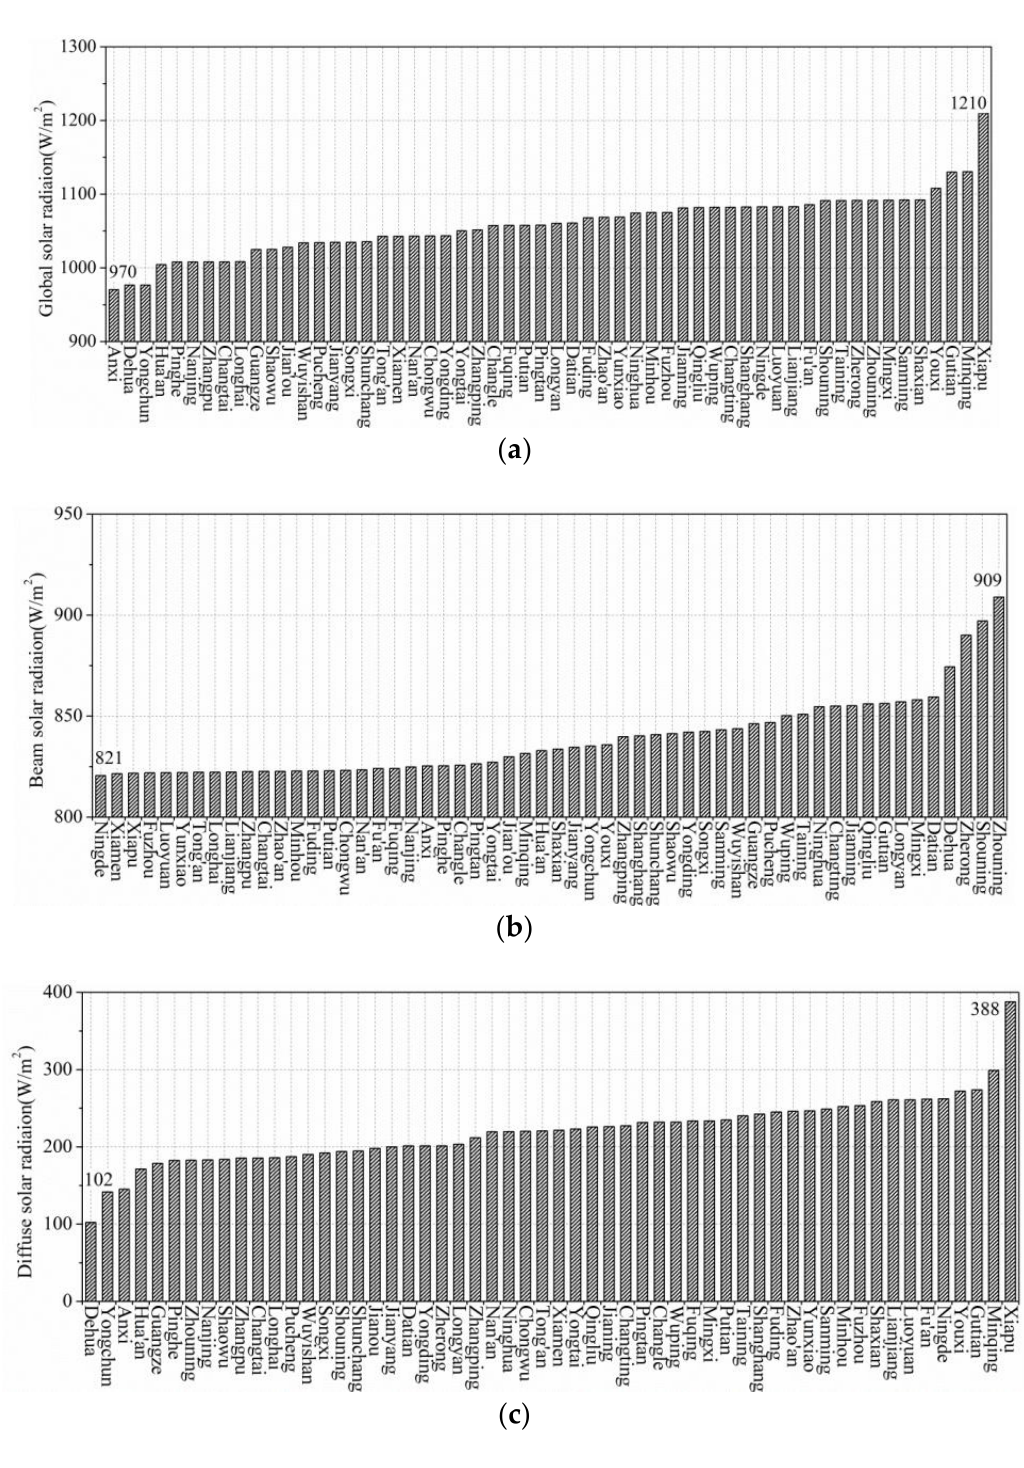
Figure 8. Maximum solar radiation for 56 cities in Fujian: ( a ) maximum global solar radiation; ( b ) maximum beam solar radiation; and ( c ) maximum diffuse solar radiation.